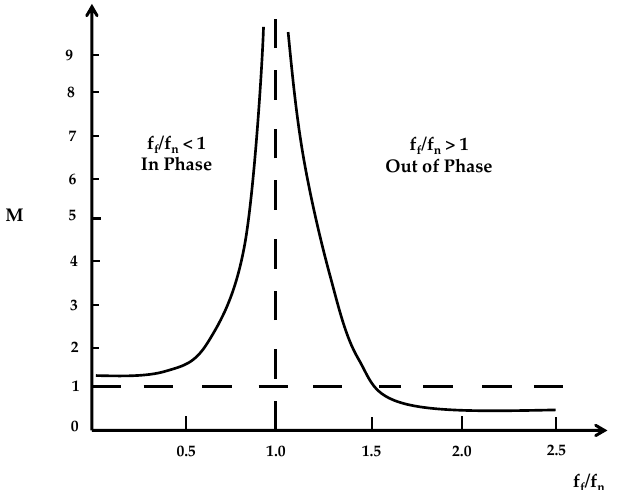
Figure 4. Magnification of an undamped spring system.